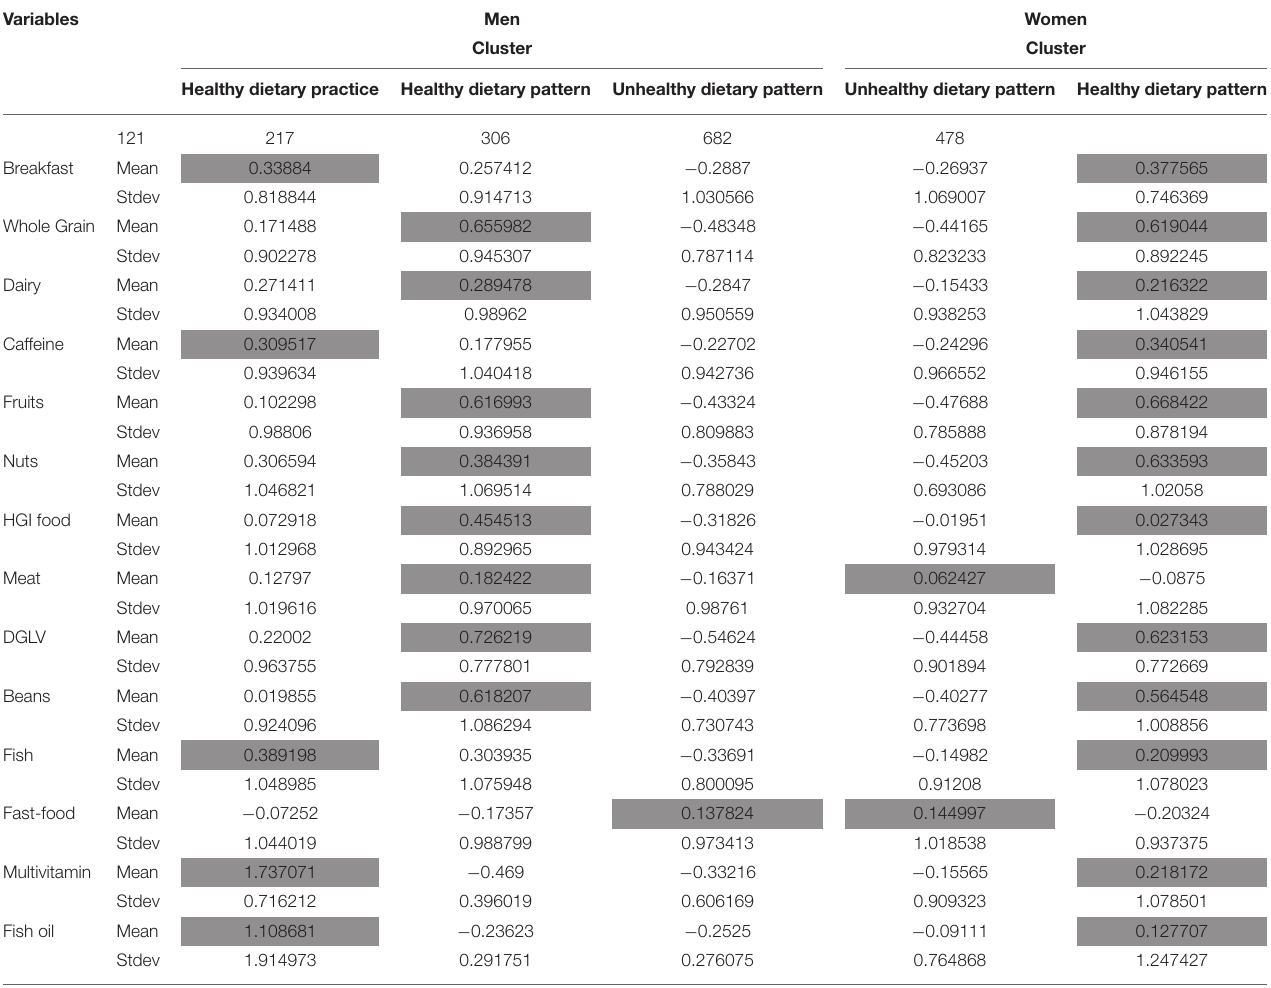
TABLE 2 | Means and standard deviations of food groups by dietary patterns, clusters of shaded values represent the variables with the highest frequencies between clusters.